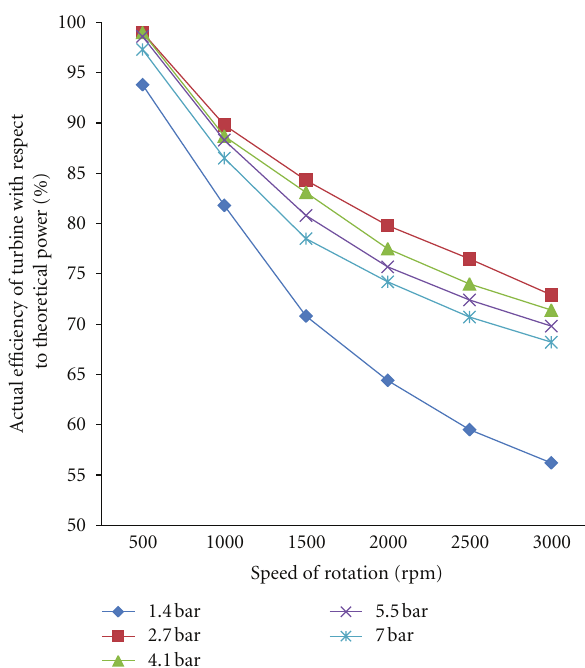
Figure 11: Actual performance of vane turbine with respect to theoretical